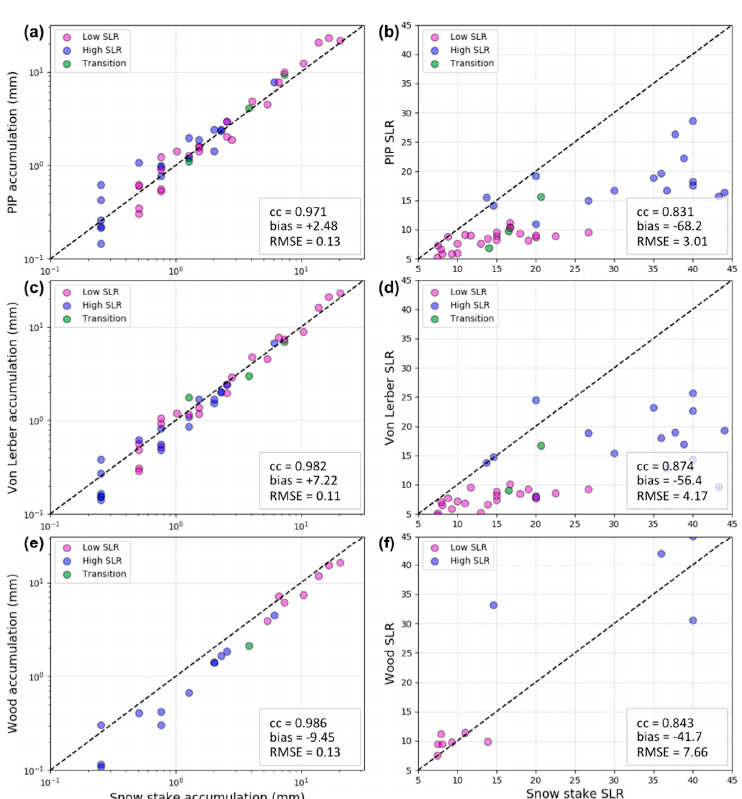
Figure 9. Displayed are comparisons of the 6-hourly accumulations from the PIP, von Lerber, and Wood output to corresponding times from the National Weather Service (NWS) Marquette, Michigan (MQT) snow field observations (x-axes). ( a ) shows the PIP accumulations (46 6 h periods), ( c ) shows the von Lerber accumulations (44 6 h periods), and ( e ) shows the Wood accumulations (22 6 h periods). Shown also are the 6-hourly NWS MQT calculations of SLR (x-axes) matched to the median values for the same time periods for the three retrievals (right panels). ( b ) shows the PIP median SLR, ( d ) shows the von Lerber median SLR, and ( f ) shows the Wood median SLR. The black dashed line represents a 1:1 relationship. Low SLR samples are in magenta, high SLR samples are in blue, and transition events are in green.